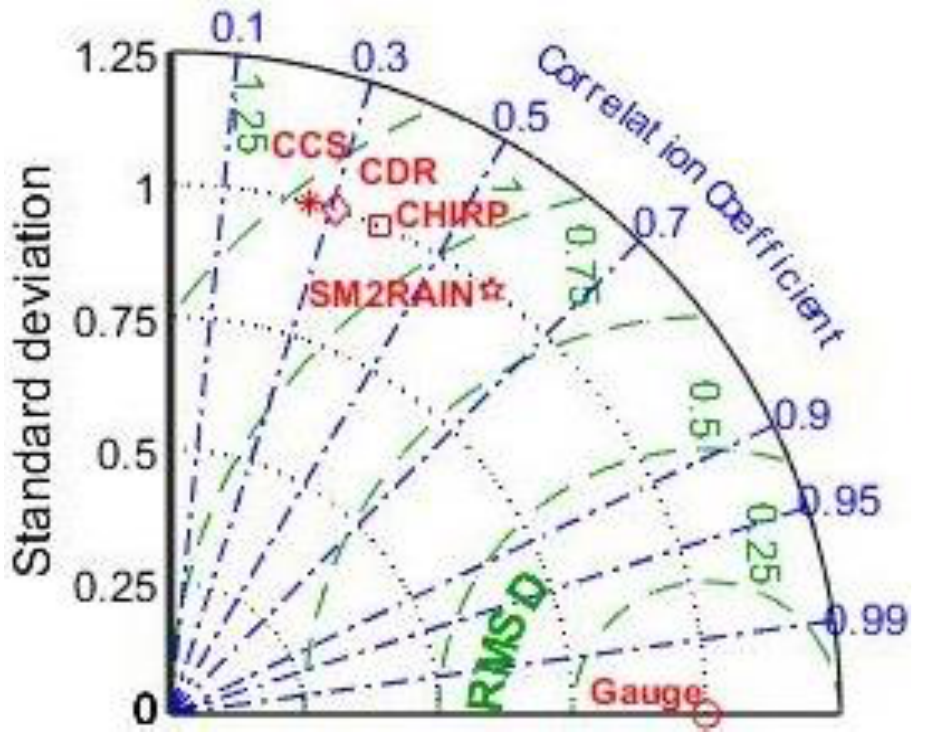
Figure 7. Taylor diagram presenting the summary of the performances of the PERSIANN-CCS, PERSIANN-CDR, CHIRPS, and SM2Rain products with reference to the daily weather station-based data.